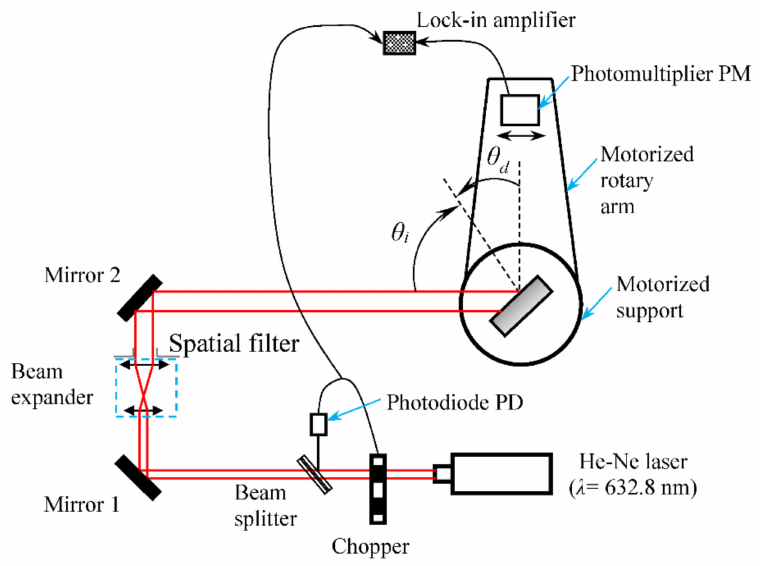
Figure 2. Bi-directional transmission/reflection measurement system based on the laser chopper system